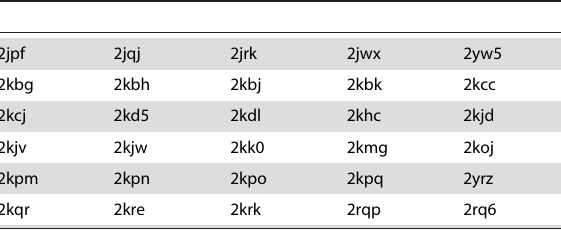
Table 2. NMR structures used to test the prediction of disordered internal